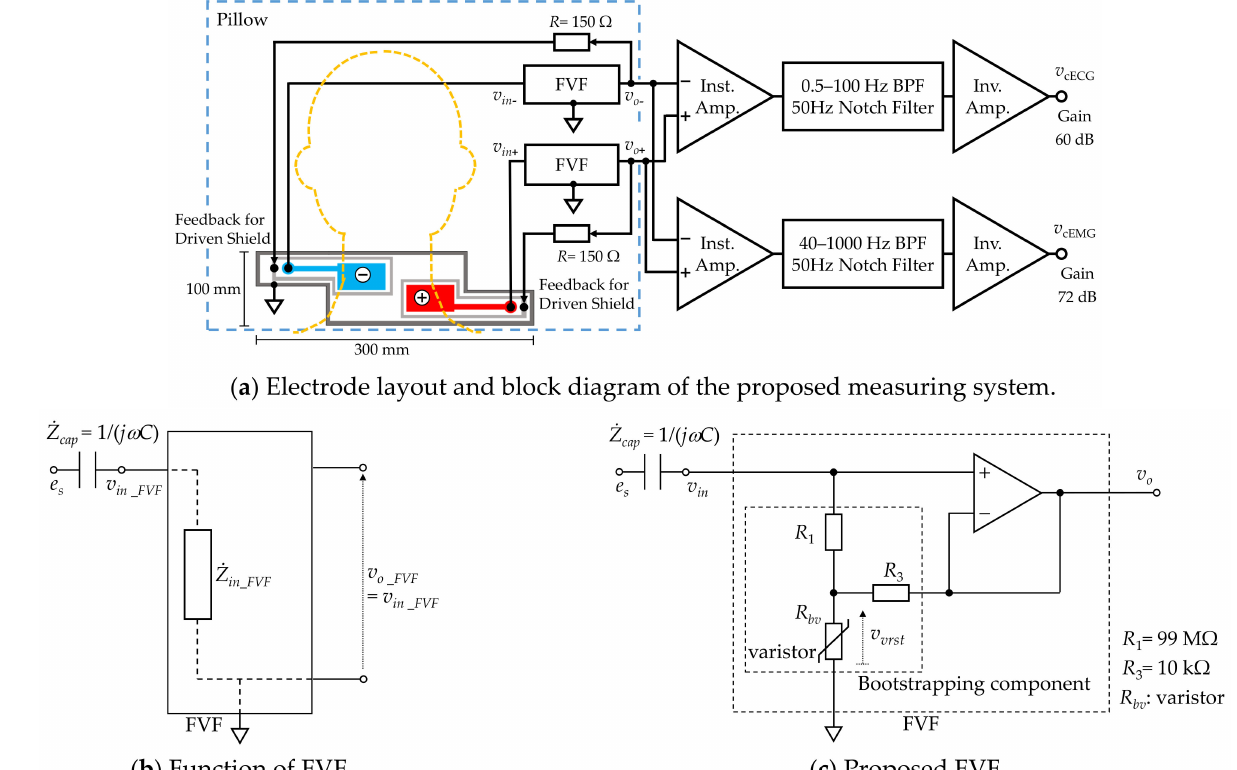
Figure 2. Proposed measuring system. ( a ) Electrode layout and block diagram. ( b ) Function of front-end voltage follower (FVF) in capacitive biopotential measurements ( c ) Circuit diagram of the FVF employed in the measuring system. A bootstrapping technique and varistor element were adopted to increase the voltage-dependent input